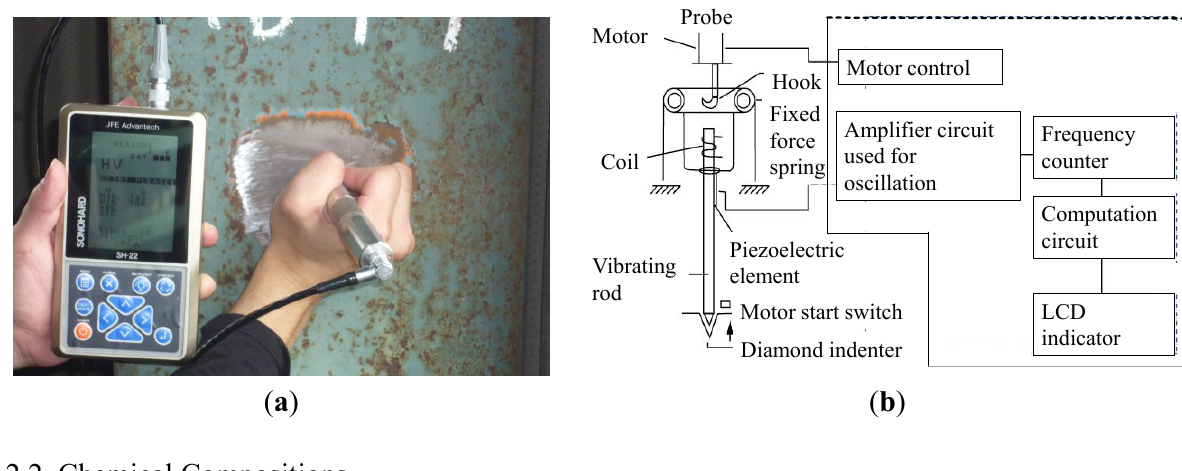
Figure 5. ( a ) Portable hardness tester; and ( b ) measurement principle of the portable hardness tester.